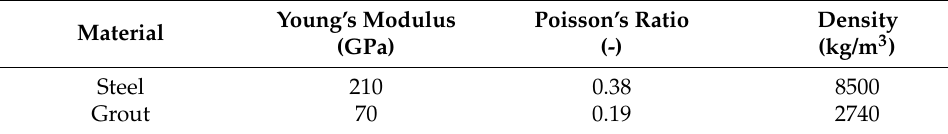
Table 2. Material properties of steel, grout [36].